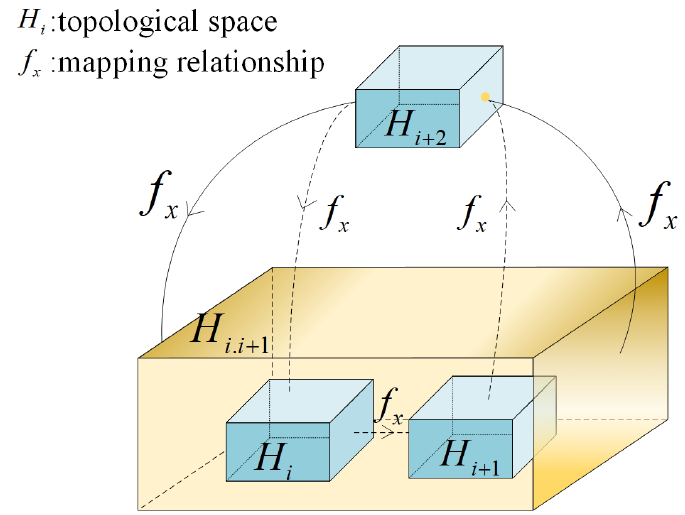
Figure 6. The mapping relationship between topological spaces in proposed topology.